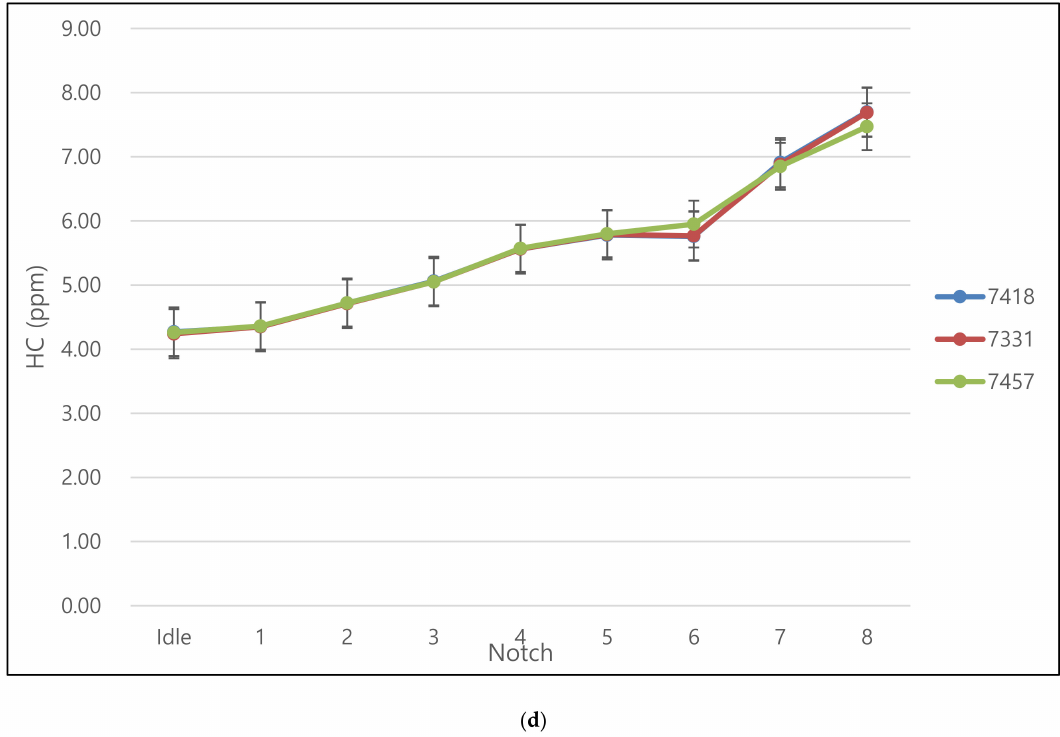
Figure 3. ( a ) Change in particulate matter concentration by notch; ( b ) change in nitrogen oxide concentration by notch; ( c ) change in carbon monoxide concentration by notch; and ( d ) change in total hydrocarbon concentration by